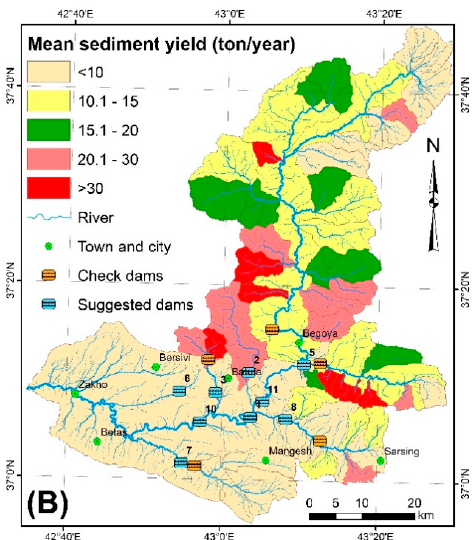
Figure 11. Map showing the distribution of ( A ) sediment delivery ratio (SDR), and ( B ) the average sediment yield within the sub ‐ basins of the KhRB. Location of dam sites recommended in an early study by [48] along with proposed check dams are indicated in